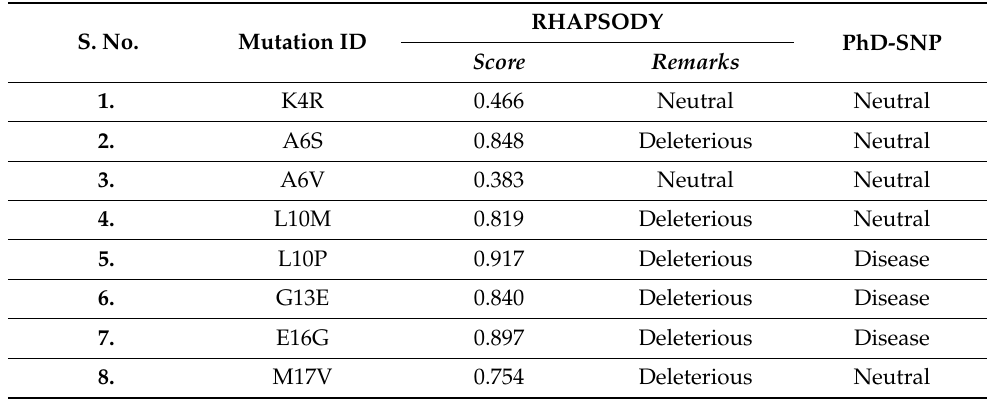
Table 1. Identification of disease phenotype by using Rhapsody and PhD-SNP of high confidence missense variants of PARK7